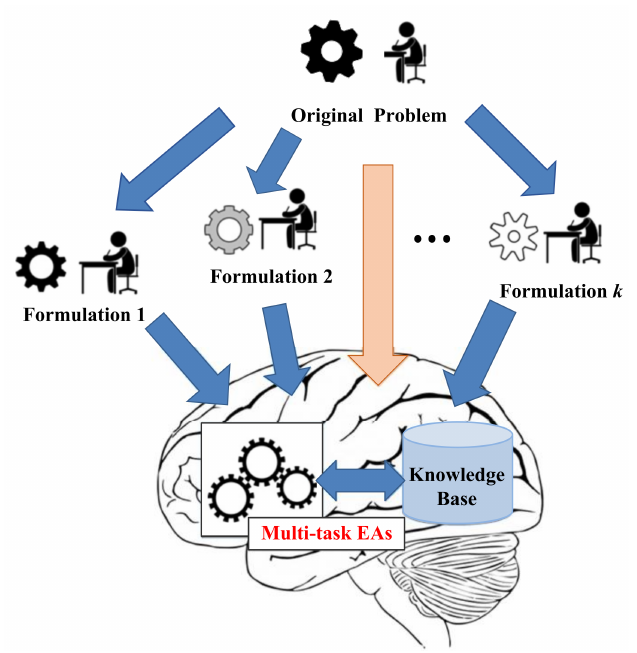
Figure 4. An illustration of multi-form optimization problem